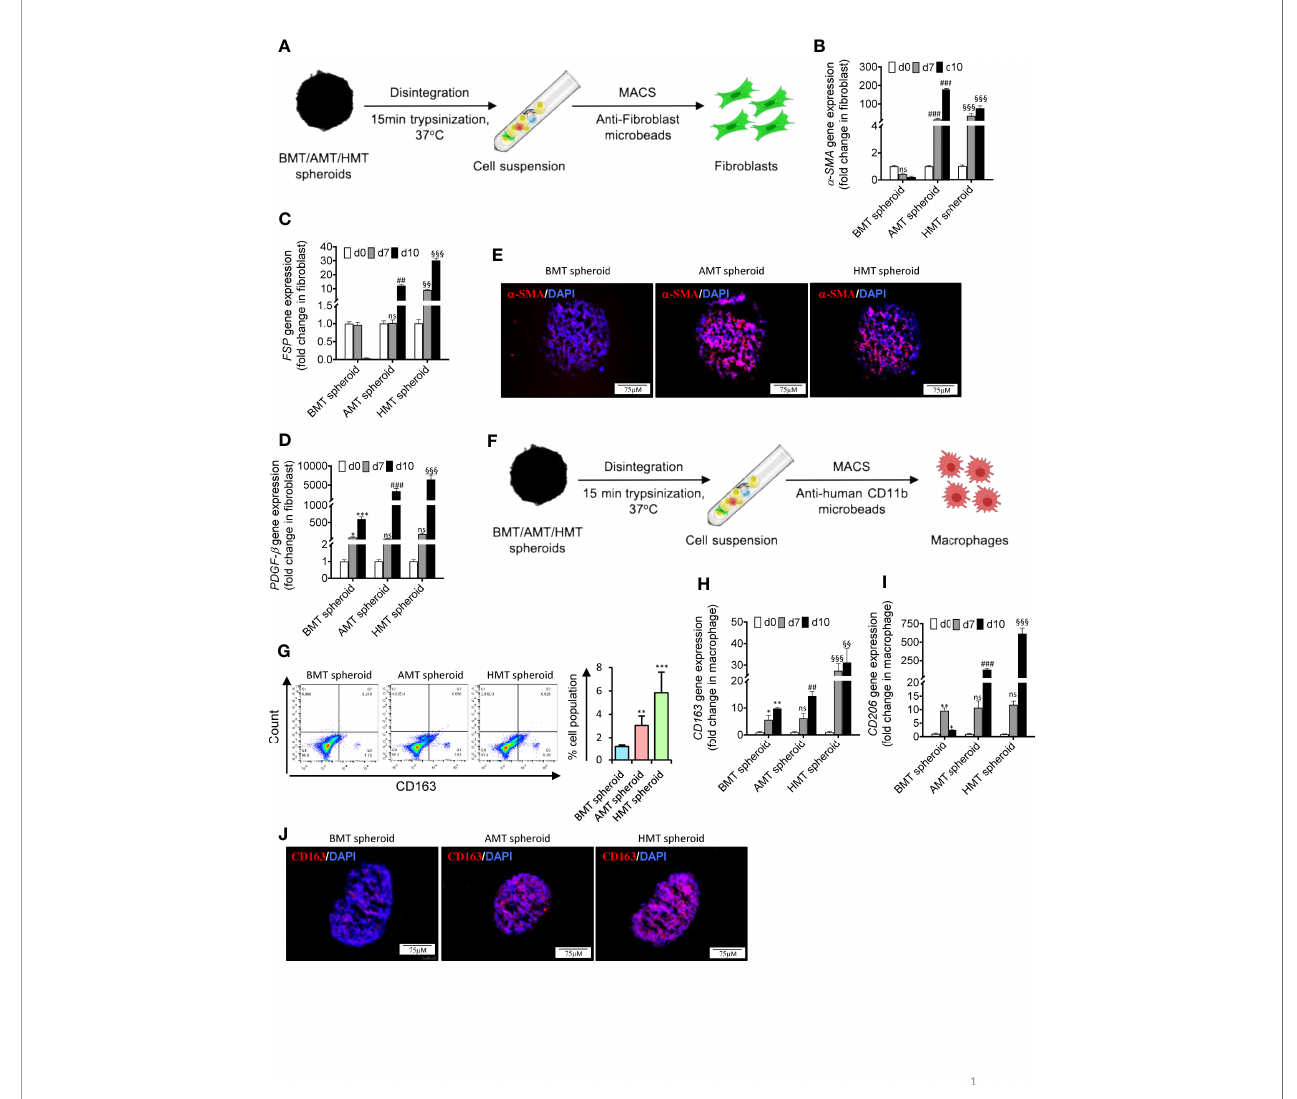
FIGURE 4 | Fibroblast activation and monocyte TAM polarization in tumorigenic multicellular 3D spheroids. (A) Schematic diagram representing isolation of fi broblasts from 3D multicellular spheroids using anti- fi broblast microbeads-based cell sorting to examine CAF markers such as a -SMA, FSP/S100A4, and PDGF- b . (B – D) RT- qPCR analysis shows a relative abundance of a -SMA (B) , FSP (C) , and PDGF- b (D) mRNA levels in isolated fi broblasts of BMT, AMT, and HMT spheroids on day 0, day 7, and day 10. (E) Immuno fl uorescence staining of a -SMA in BMT, AMT, and HMT spheroid sections (6 micron). DAPI was used for nuclei counterstaining. (F) Schematic diagram representing isolation of macrophages from 3D multicellular spheroids using anti-human CD11b microbeads to examine TAM markers CD163 and CD206. (G) Flow cytometric analysis and quanti fi cation of CD163+ cells in BMT, AMT, and HMT spheroids on day 10. (H, I) RT-qPCR analysis of CD206 (H) and CD163 (I) gene expression in macrophages isolated from BMT, AMT, and HMT spheroids on day 0, day 7, and day 10. (J) Immuno fl uorescence staining of CD163 in BMT, AMT, and HMT spheroid sections (6 micron). DAPI was used for nuclei counterstaining. GAPDH is used as a loading control for RT-qPCR analysis. Fold change for CAF markers was calculated keeping MRC5 as control cells and fold change for TAM population was calculated keeping THP-1 cells as control cells. All experiments were performed in triplicate (n=3). Data represented as mean ± S.D. 2D vs BMT over time *p< 0.05, **p< 0.01, ***p< 0.001; BMT vs AMT over time ## p< 0.01, ### p< 0.001; BMT vs HMT over time §§ p< 0.01, §§§ p< 0.001; ns, non-signi fi